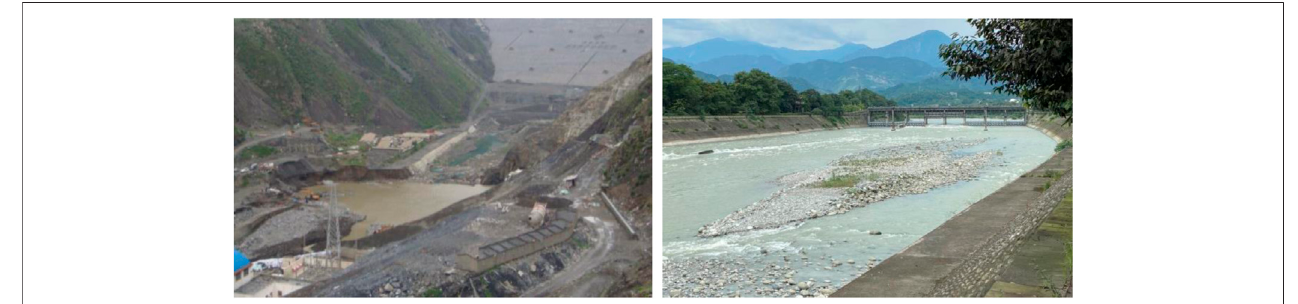
FIGURE 1 | Field sampling of water